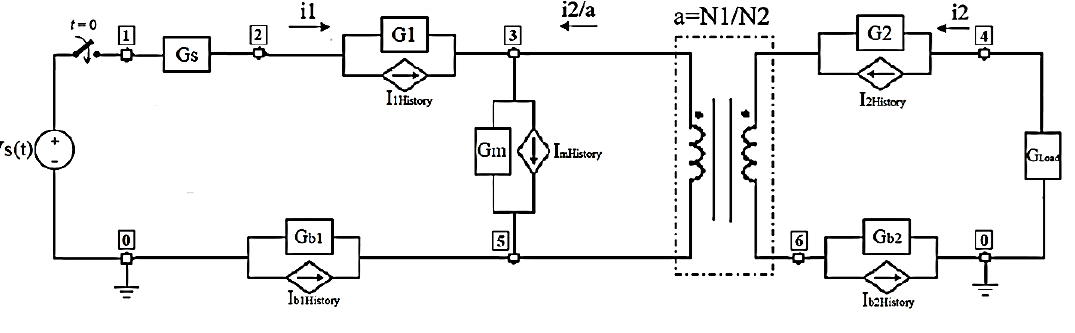
Figure 11. Discrete version of the test circuit.